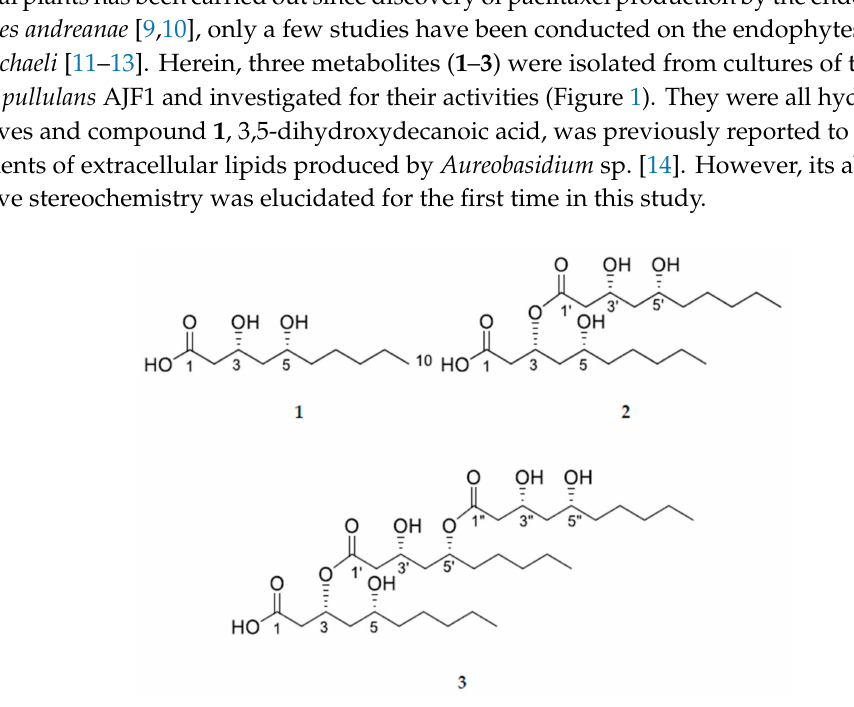
Figure 1. Structures of (3 R ,5 R )-3,5-dihydroxydecanoic acid ( 1 ), (3 R ,5 R )-3-(((3 R ,5 R )-3,5-dihydroxy decanoyl)oxy)-5-hydroxydecanoic acid ( 2 ), and (3 R ,5 R )-3-(((3 R ,5 R )-5-(((3 R ,5 R )-3,5-dihydroxydecan oyl)oxy)-3-hydroxydecanoyl)oxy)-5-hydroxydecanoic acid ( 3